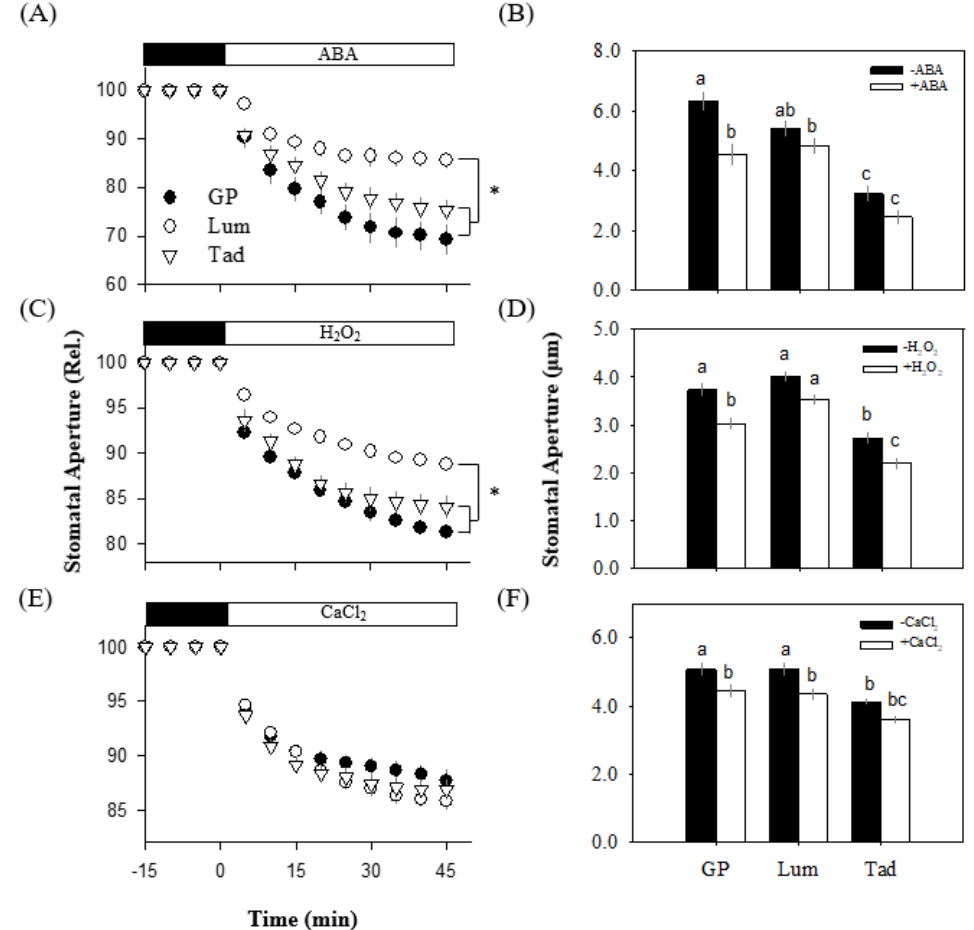
Figure 5. ABA-, H 2 O 2 - and CaCl 2 -induced stomatal closure in barley. Stomatal closure and parallel aperture induced by adding 100 µ M ABA ( A , B ), 100 µ M H 2 O 2 ( C , D ), and 10 mM CaCl 2 ( E , F ) in GP (black circles), Lum (white circles), and Tad (white triangles) guard cells. Apertures were normalized on a cell-by-cell basis to values at a time point 15 min before treatments. Stomata were pooled from four independent experiments for each line. Data are presented as the means ± se ( n = 30—40). Different letters above the error bars and * indicate significant differences at p < 0.05.